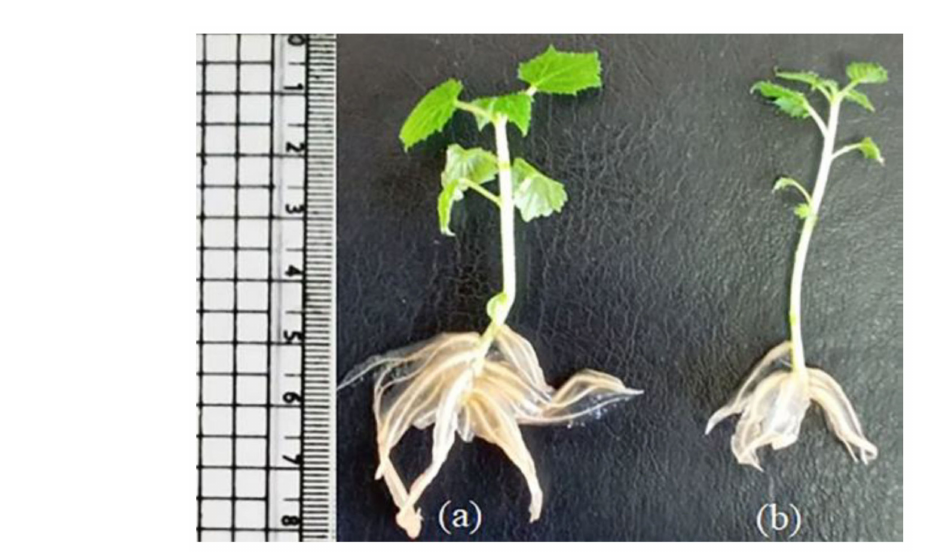
Figure 3. In vitro root formation on microshoots that were grown on MS medium containing 2 mg/L BAP and 0.1 mg/L NAA ( a ) without or ( b ) with 0.1 mg/L GA and were cultured for three weeks on semisolid half-strength MS medium with 0.5 mg/L IBA and 0.5 mg/L